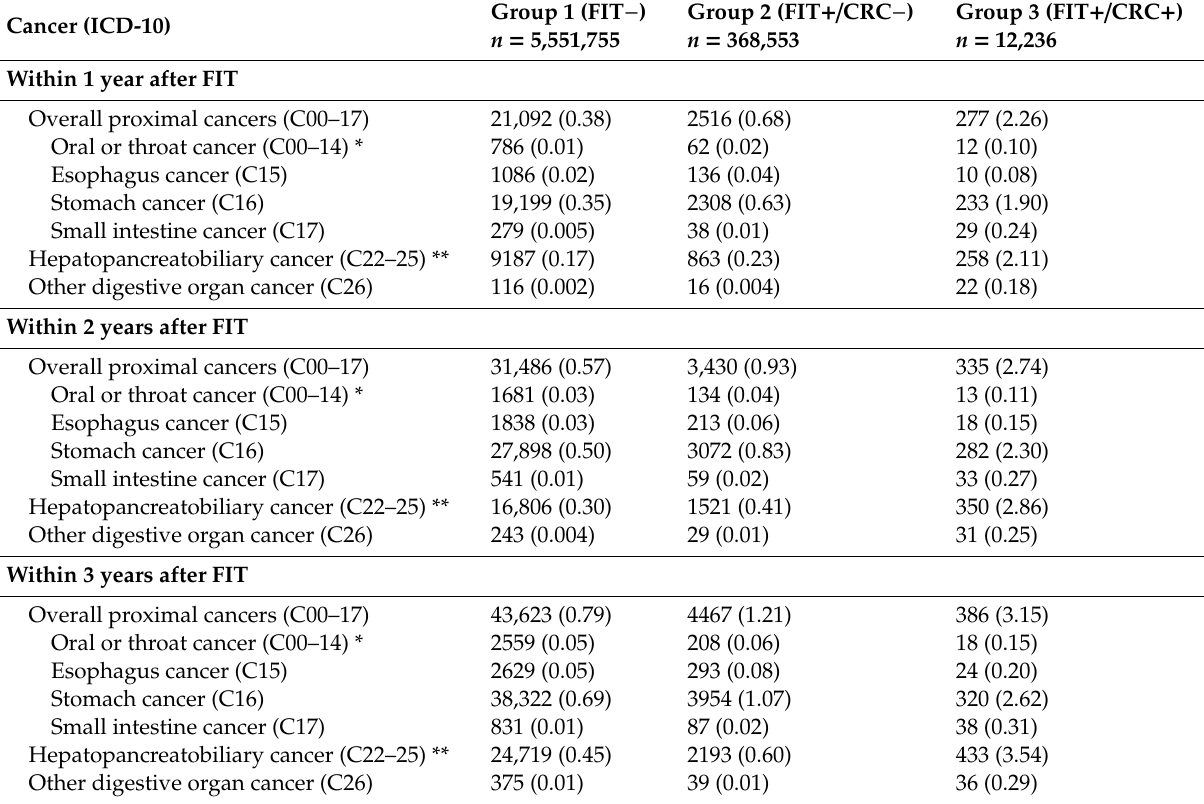
Table 2. Locations and incidences of proximal cancers according to FIT results and the presence of